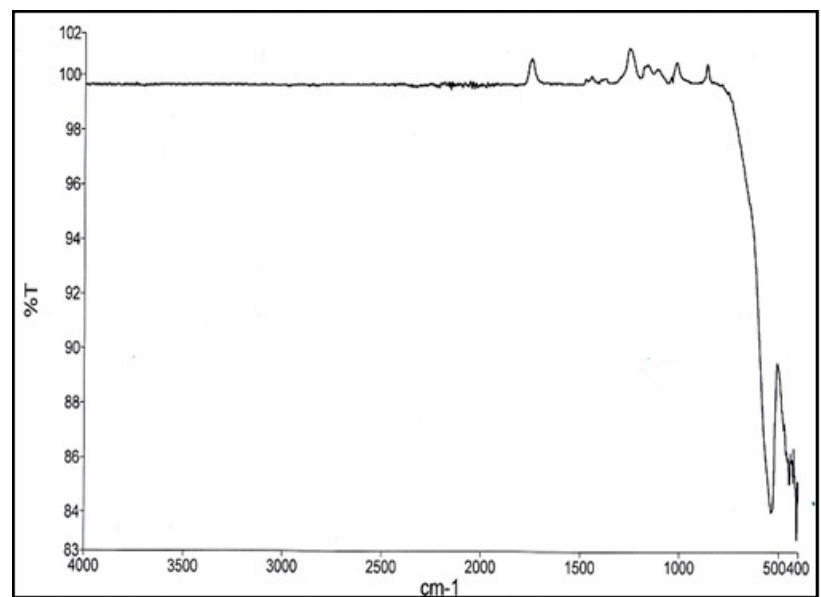
Figure 11. FTIR of Co 0.5 Al 0.3 Fe 1.7 O 0.4.